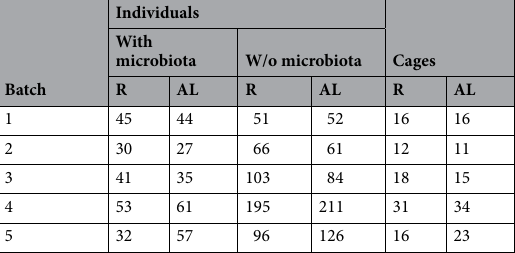
Table 9. Number of individual and cages within feeding regime and batch. Animals with microbiota assessed and non-assessed are distinguished for the individual records. R, animals under restriction; AL, animals fed ad libitum.